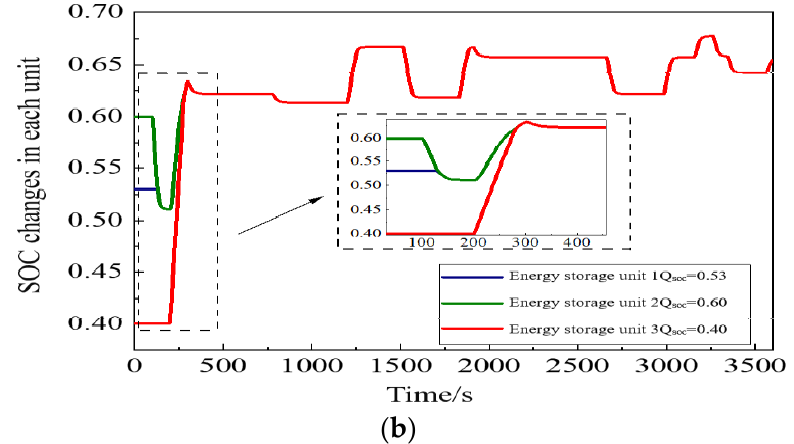
Figure 8. SOC changes of energy storage unit under two distribution methods. ( a ) SOC changes of each unit under the traditional average distribution. ( b ) SOC changes in the allocation of units under the proposed optimization method.